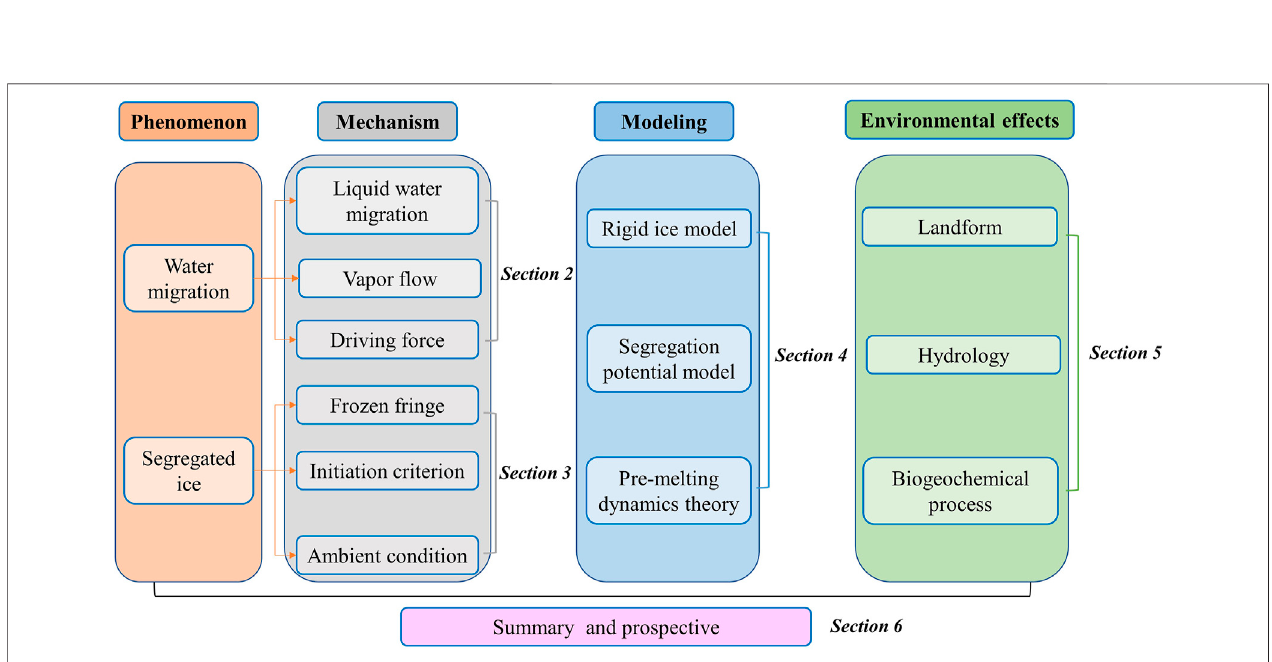
FIGURE 2 | A diagram illustrating the overall framework and linkages of different sections in this article.